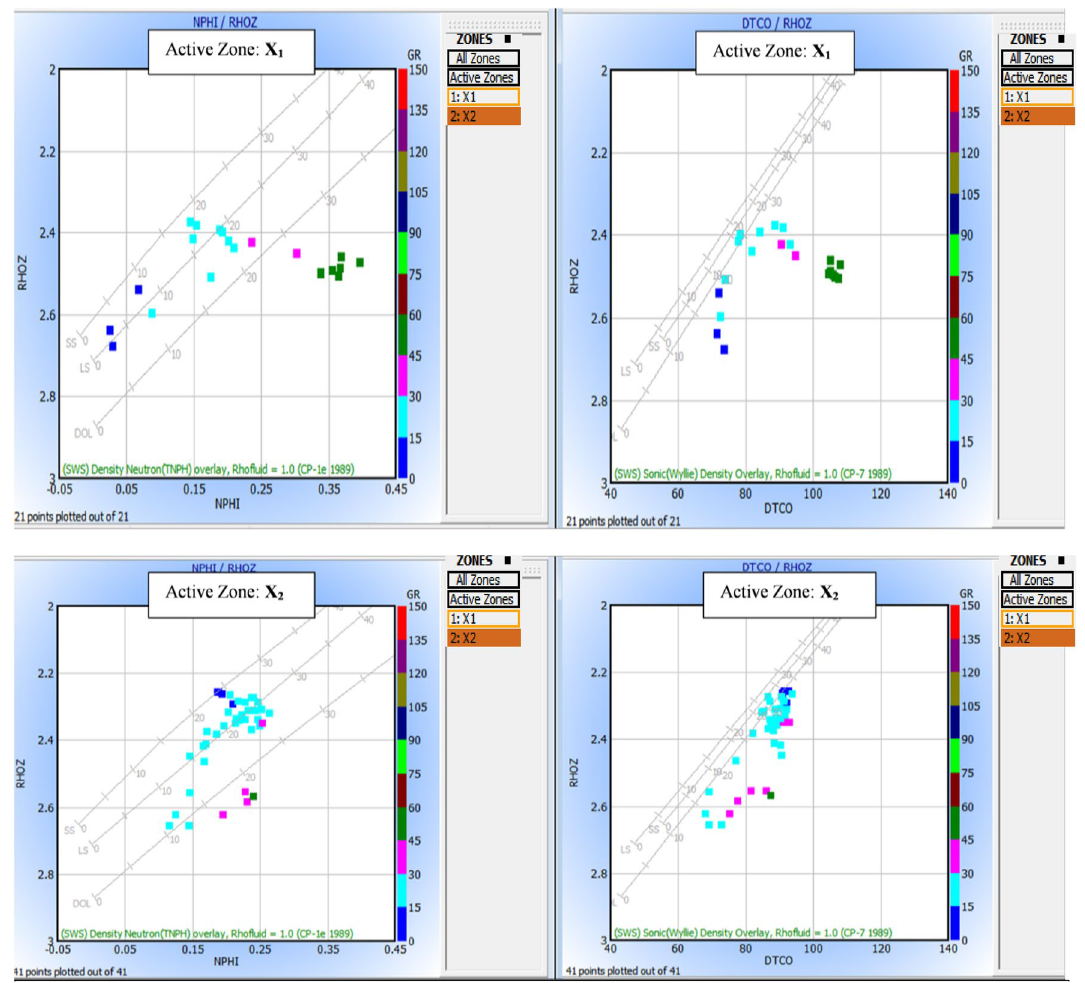
Fig. 10 Density-neutron and sonic-density for Well X reservoirs depicting points scattered across the various lithological field indicating the het- erogeneous character of the